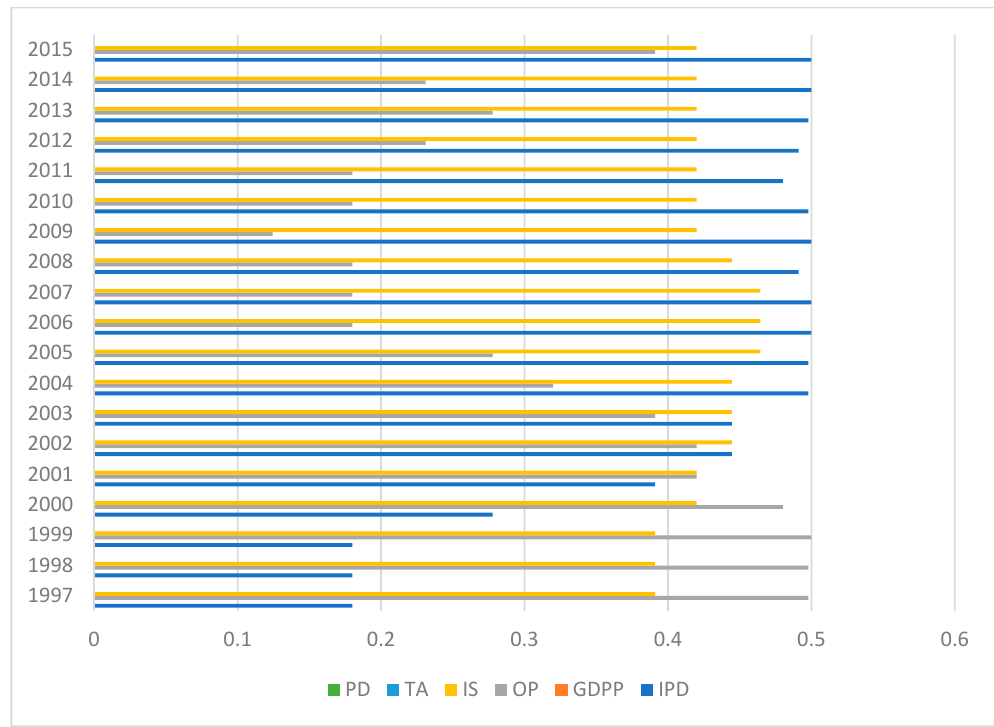
Figure 8. Spatial heterogeneity in time dimension.